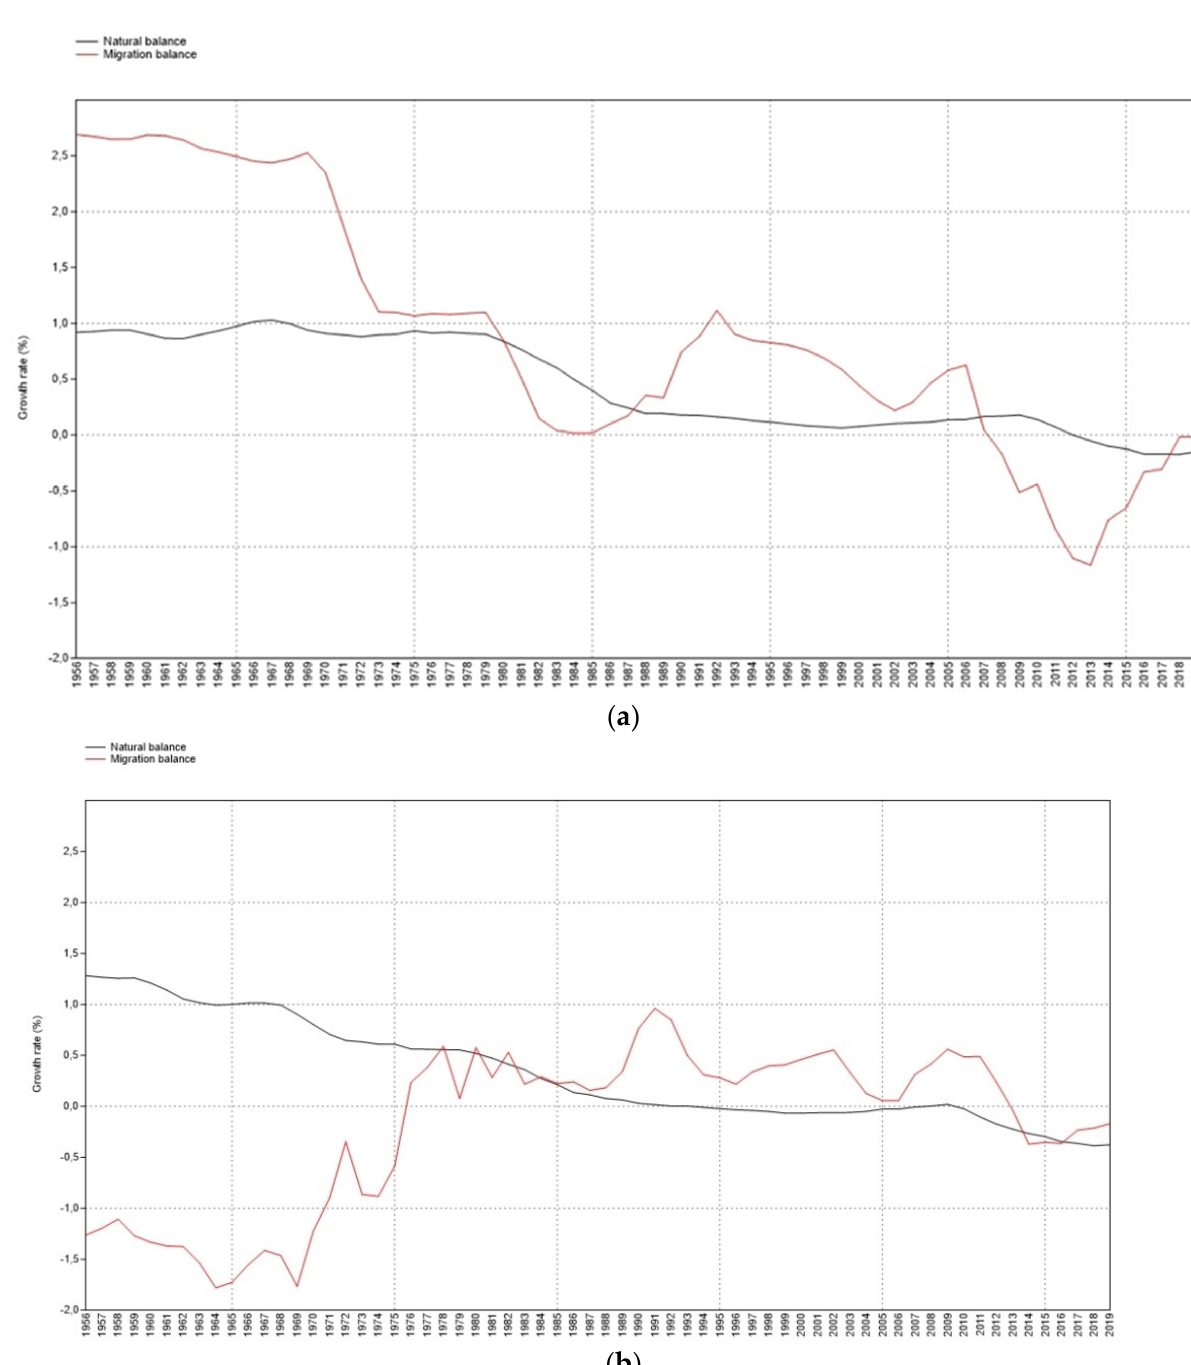
Figure 3. Trends over time in natural population balance and migration balance ( a ) in Attica and ( b ) in the rest of Greece (source: our elaboration on Eurostat regional statistics).